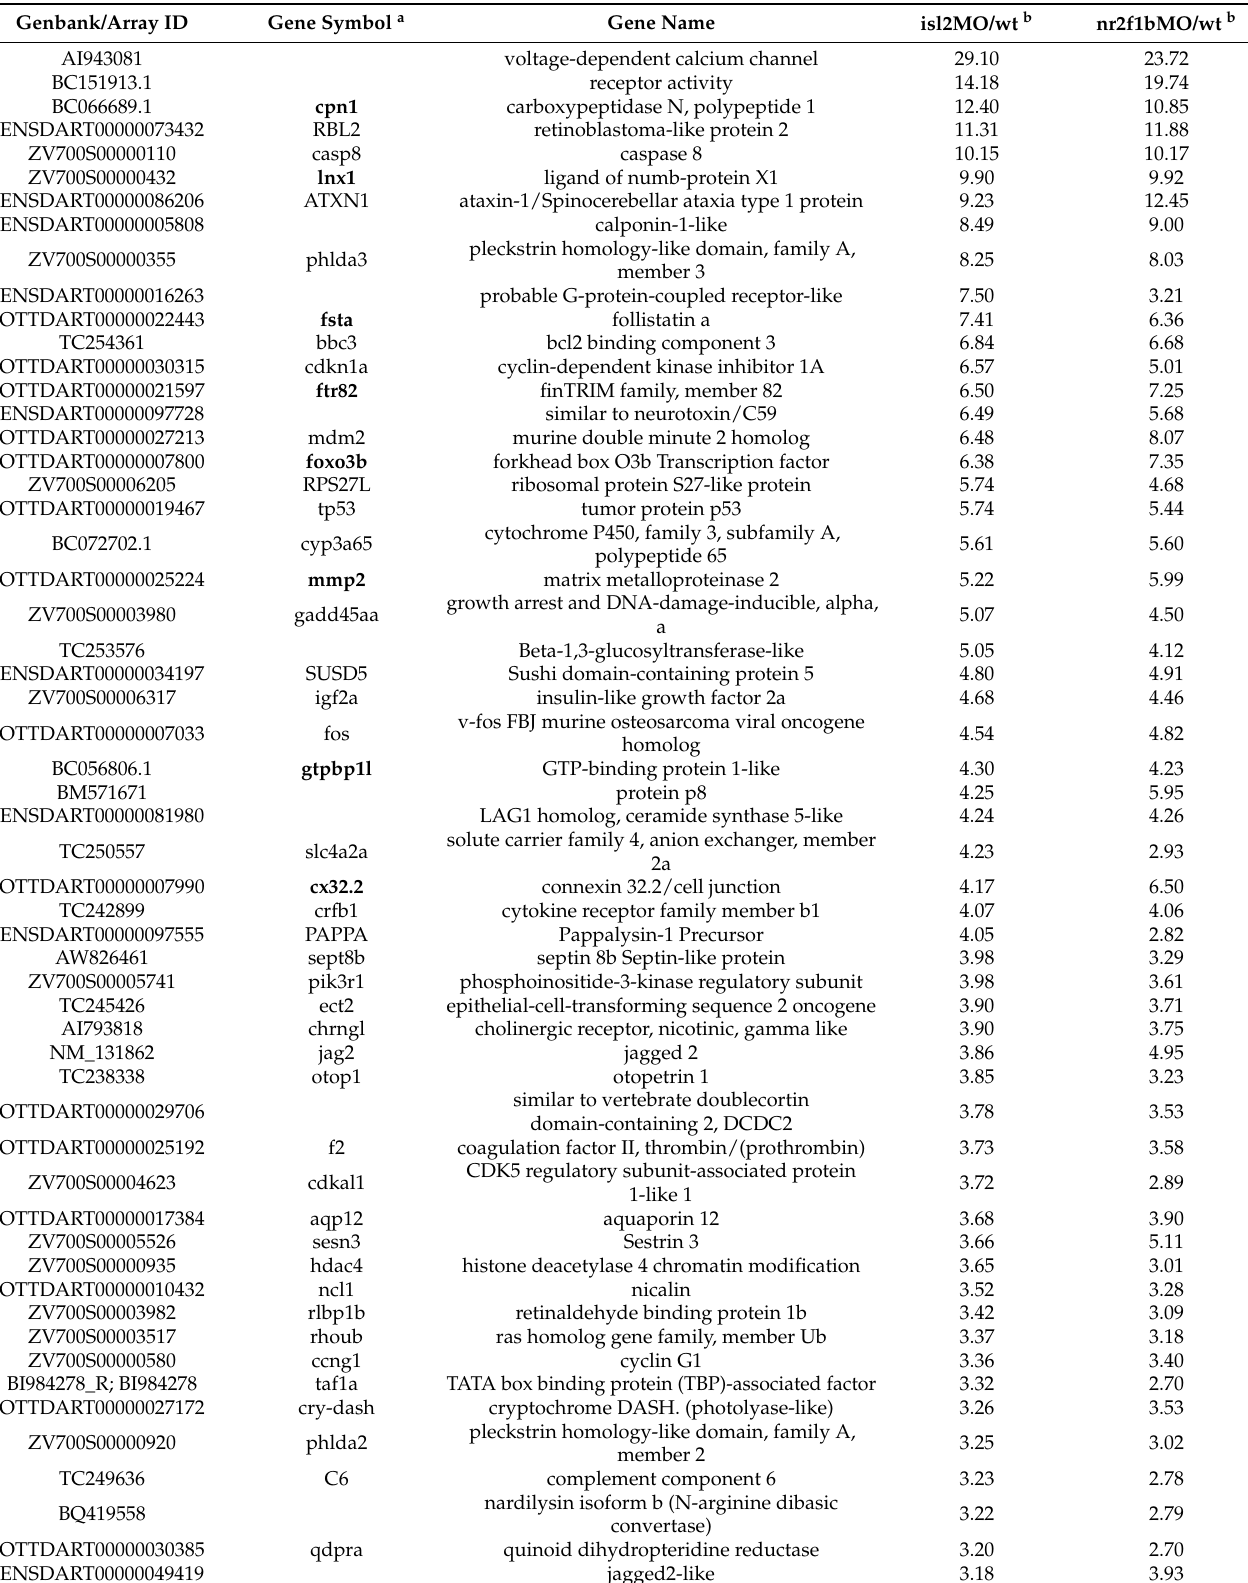
Table 1. Genes that are up-regulated ≥ 2.5-fold in both isl2 MO and nr2f1b